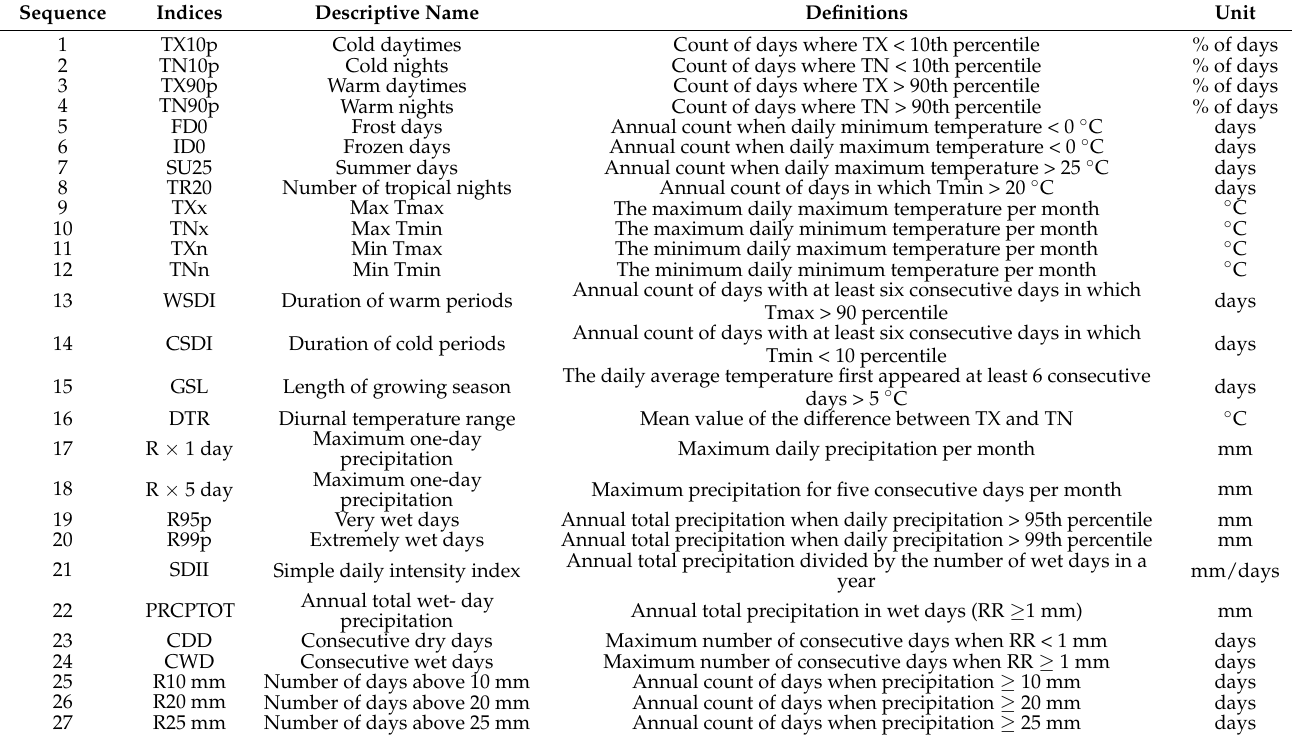
Table 1. Definition of Extreme precipitation and temperature